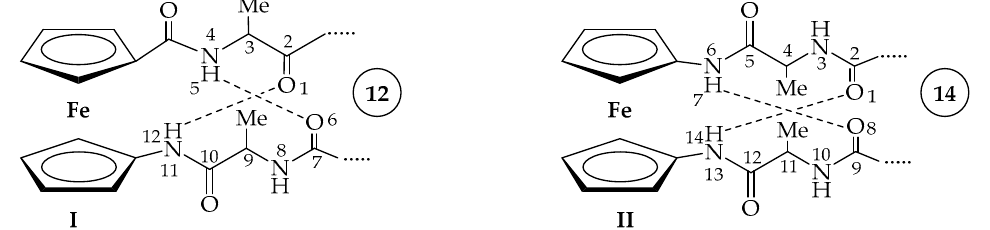
Figure 1. The symmetrically disubstituted peptidomimetics containing turn-inducing ferrocene templates -NH-Fn-CO- ( I ) and -NH-Fn-NH- ( II ).